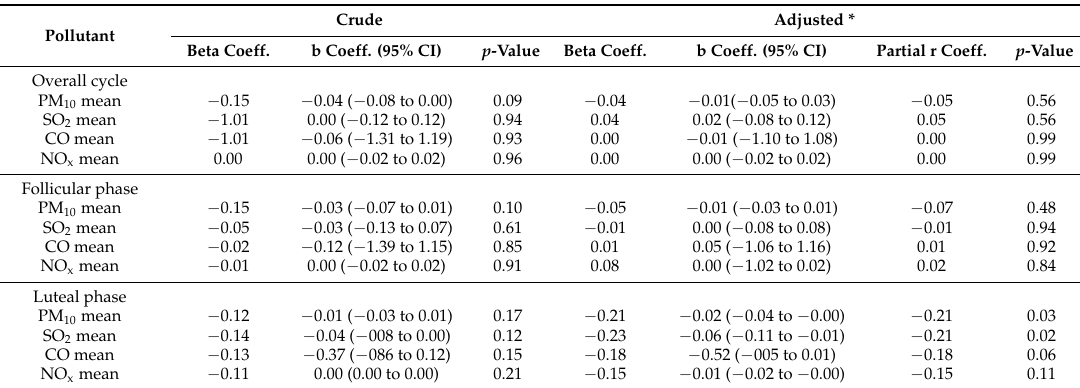
Table 5. The association between single air pollutants and menstrual overall cycle and phases length tested by simple and multiple regression